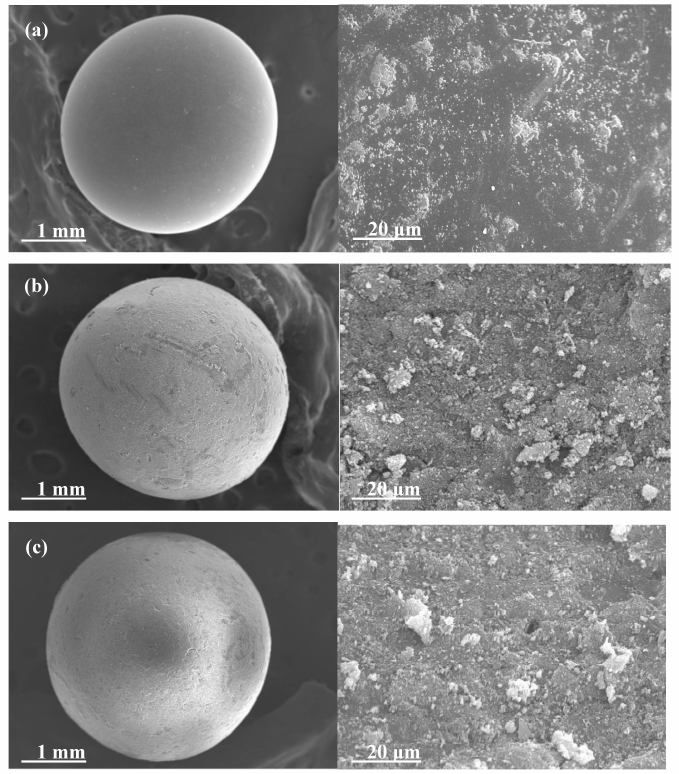
Figure 3. SEM images: ( a ) Glass sphere; ( b ) TiO 2 supported on glass spheres (TGS); ( c ) TGS after photocatalytic